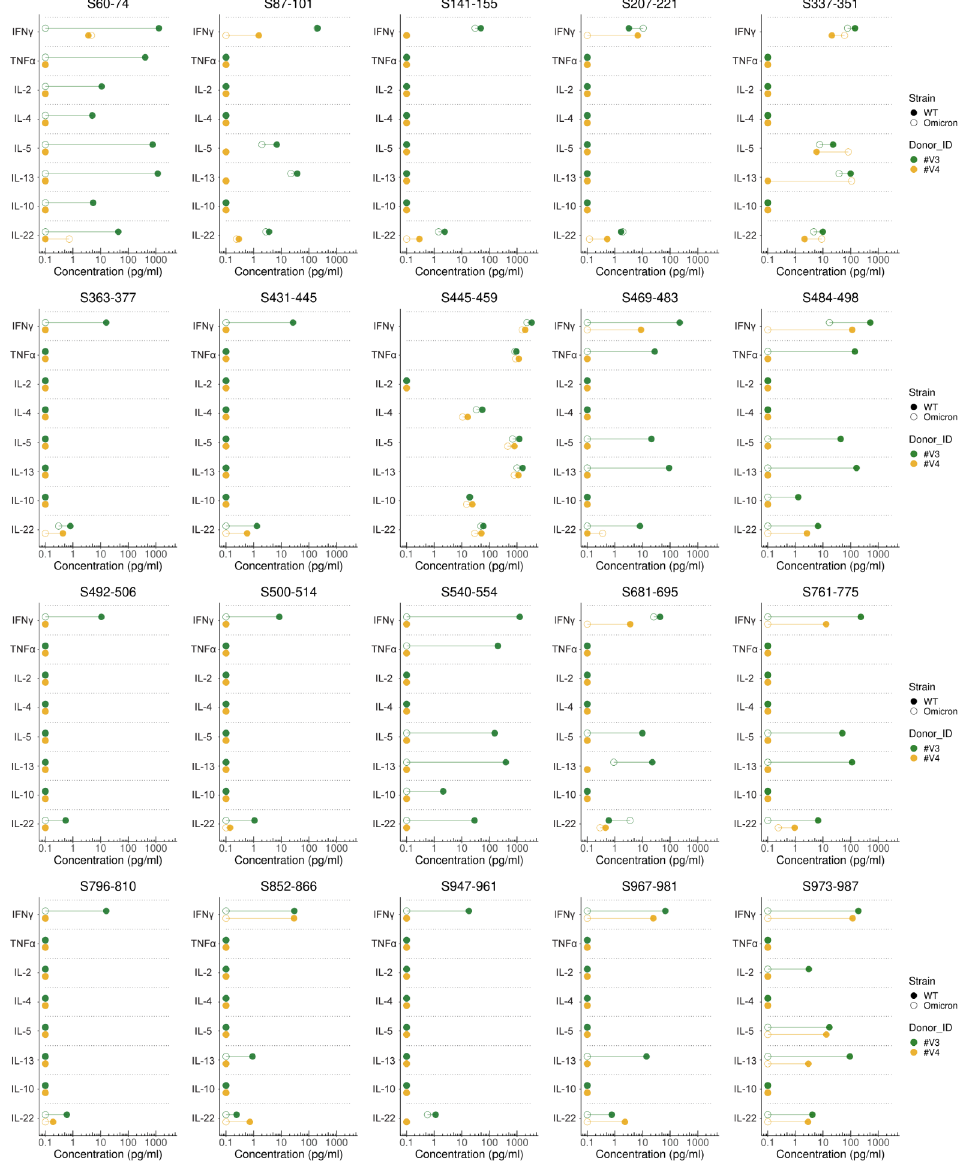
Figure 6. Reduced cytokine responses to the individual spike epitopes harboring Omicron BA.1 mutations. T-cell lines were generated by 14-day in vitro stimulation of PBMCs with a pool of se- lected CD4+ T-cell epitope candidates from the D614G wild-type (WT) strain (“WT CD4+ pool”) in the presence of IL-2. T-cell lines from two vaccinees, i.e., donor #V3 (orange) and donor #V4 (dark green), were analyzed for secretion of various cytokines detected using a flowcytometric assay. Lol- lipop plots show concentrations of different cytokines measured in T-cell line supernatants after stimulation of T cells with individual peptides of spike protein of D614G wild-type (WT) strain (closed dots) and corresponding Omicron BA.1 variant peptides (open dots). Differences between